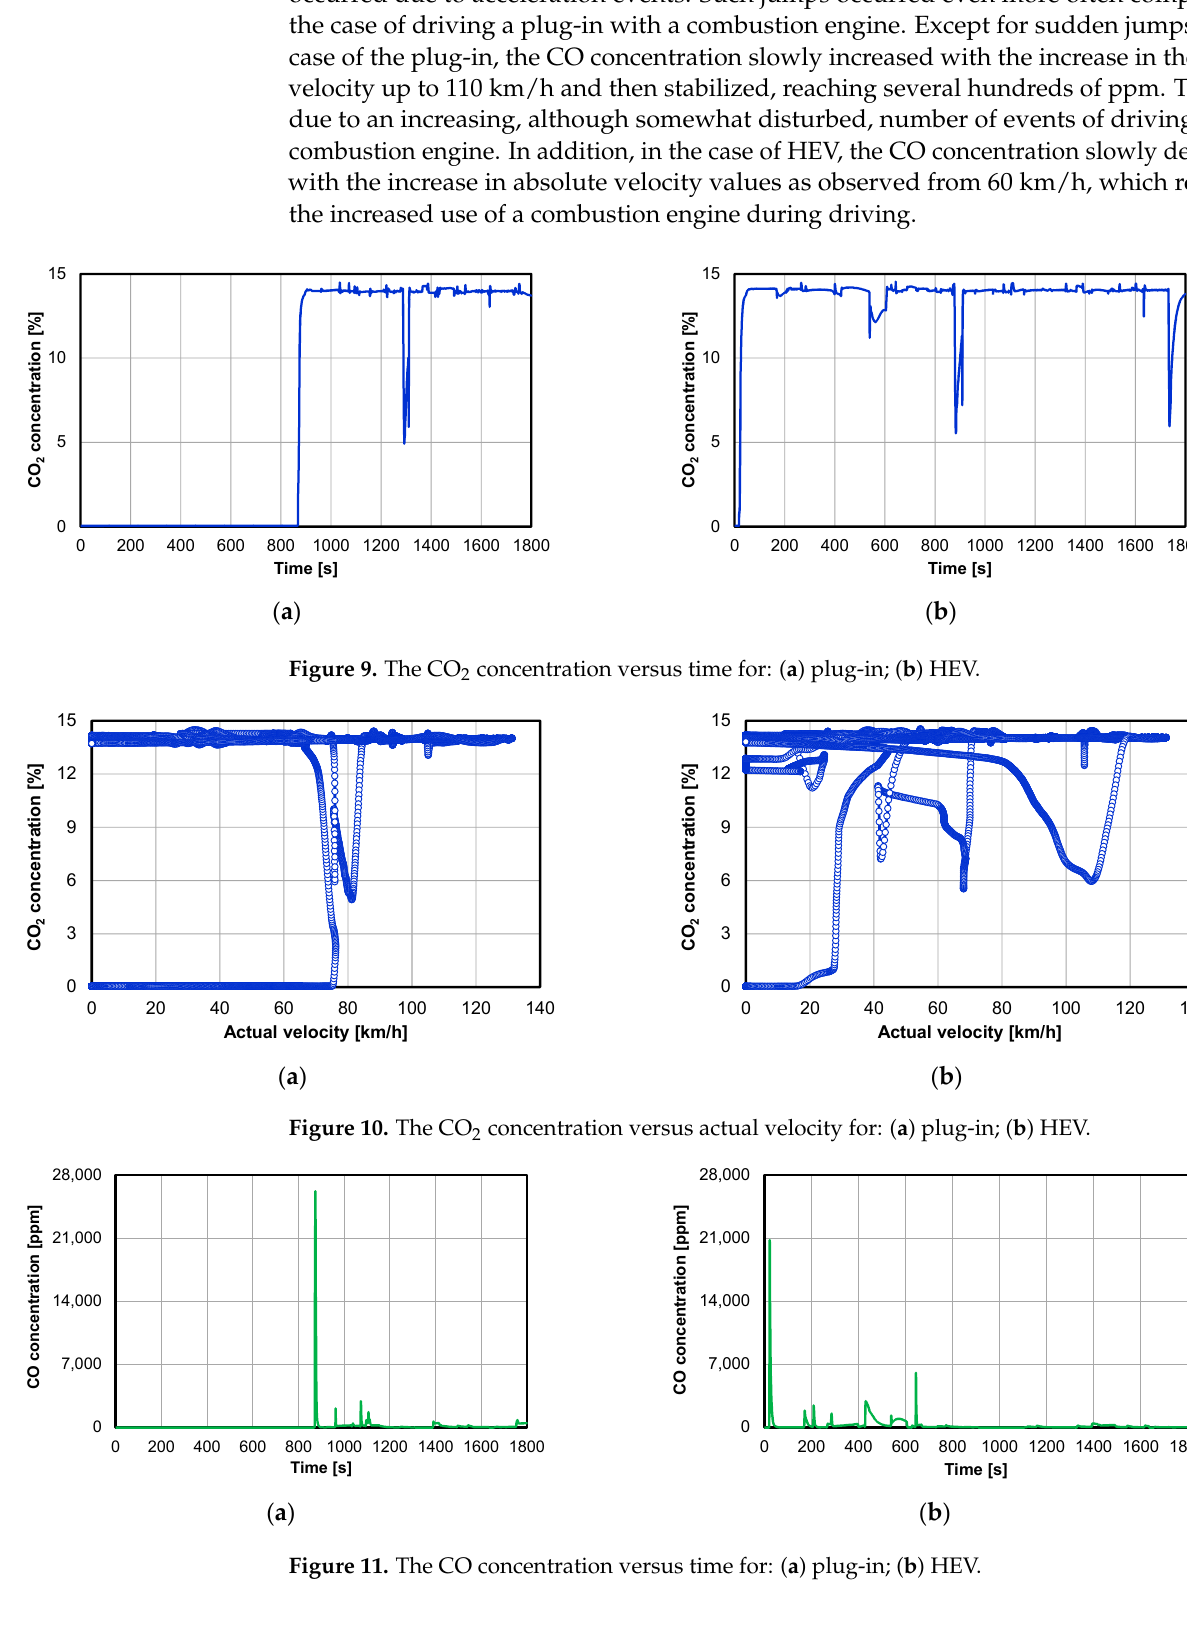
( b ) Figure 12. The CO concentration versus actual velocity for: ( a ) plug-in; ( b ) HEV. The NO x concentration during tests is shown in Figure 13a for the plug-in and in Figure 13b for HEV. The relation between NO x concentration and actual velocity is shown in Figure 14a for the plug-in and in Figure 14b for HEV. In the case of the plug-in in the first half of the test, such a concentration oscillated with positive values around the level of 0 ppm due to driving with an electric motor. In the second half of the test, such a con- centration varied between the levels of 0 and up to 10 ppm, especially for actual velocity values in the range of 30–90 km/h. This was due to driving with a competitive choice be- tween a combustion engine and electric motor. The sharp jumps observed up to 120 ppm related to the acceleration events that occurred during the test. In the case of HEV, such a concentration clearly varied for values of actual velocity in the ranges of 10–60 and 80–120 km/h. The latter was due to driving with a competitive choice between a combustion en- gine and electric motor, but the former was affected by more factors, as there were three